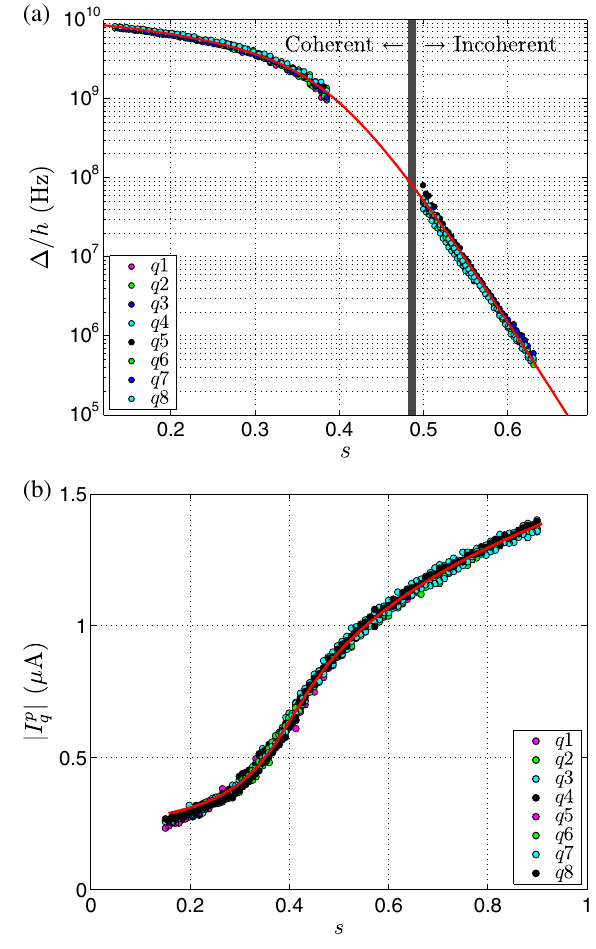
FIG. 6. (a) Δ ð s Þ versus s . We show measurements for all eight qubits studied in this work. We use a single-qubit Landau-Zener experiment to measure Δ =h < 100 MHz [39]. We use QTS to measure Δ =h > 1 GHz [33]. The red line shows the theoretical prediction for a rf SQUID model employing the median qubit parameters of the eight devices. The vertical black line separates coherent (left) and incoherent (right) evolution as estimated by analysis of single-qubit spectral line shapes. (b) j I p q jð s Þ versus s . We show measurements for all eight qubits studied in this work. We use a two-qubit coupled flux measurement with the interqubit coupling element set to 1.37 pH [8]. The red line shows the theoretical prediction for a rf SQUID model employing the median qubit parameters of the eight